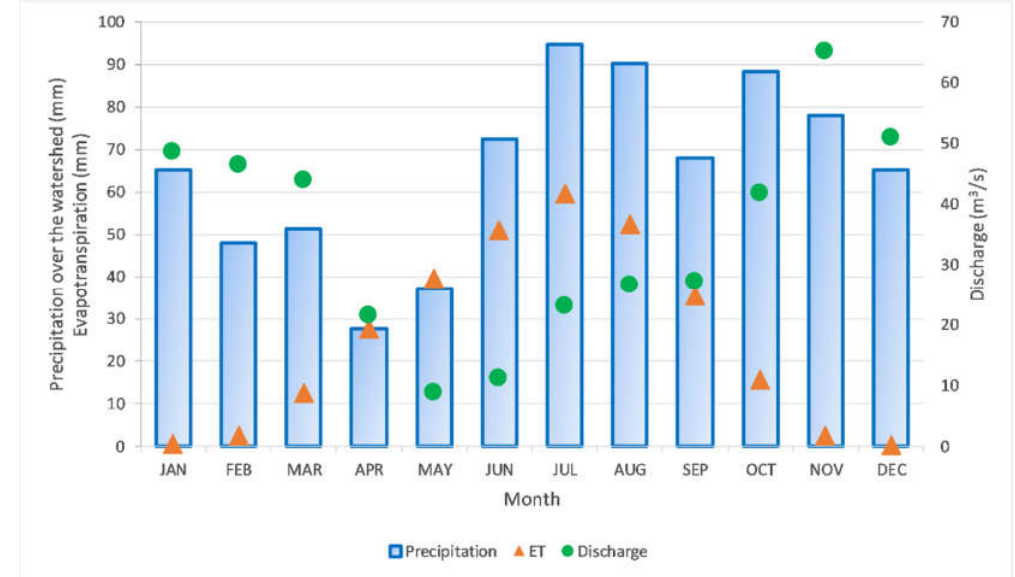
Figure 3. Mean measured monthly precipitation over the Minija River basin, estimated evapotranspiration (ET) and measured discharge in the period from 2000–2010.